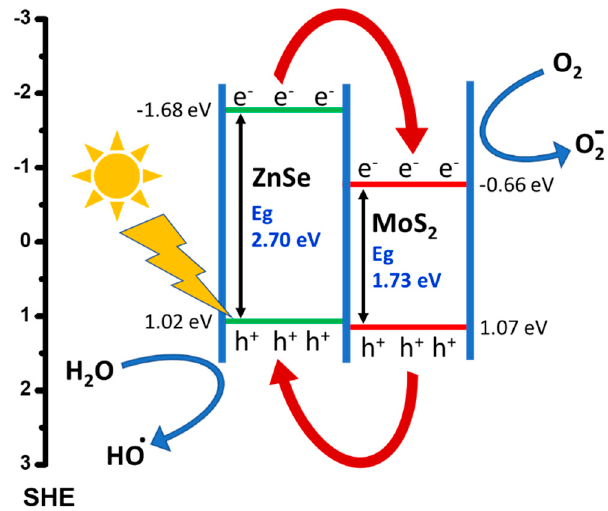
Figure 8. Schematic illustration of alignment of the energy level of 3:1 MoS 2 /ZnSe nanocomposite.